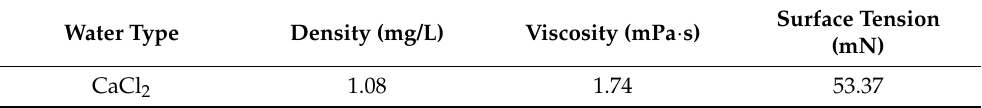
Table 2. Properties of simulated reservoir liquid.